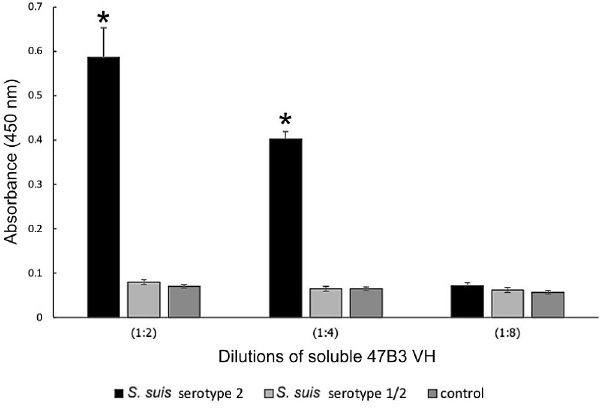
Fig 9. Specificity of soluble 47B3 VH antibody to S . suis serotypes 2 and 1/2, as tested by ELISA. Data are shown as the mean ± 1SD (n = 3). � P < 0 . 05 compared to the negative control.